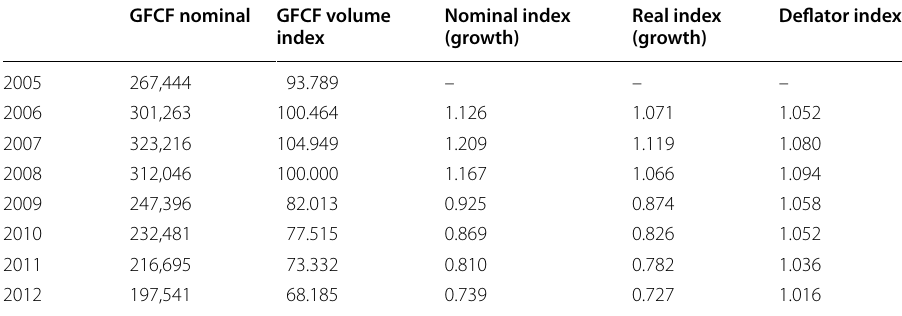
Table 2 Gross fixed capital formation (GFCF). Source INE (Spanish National Statistics Office)